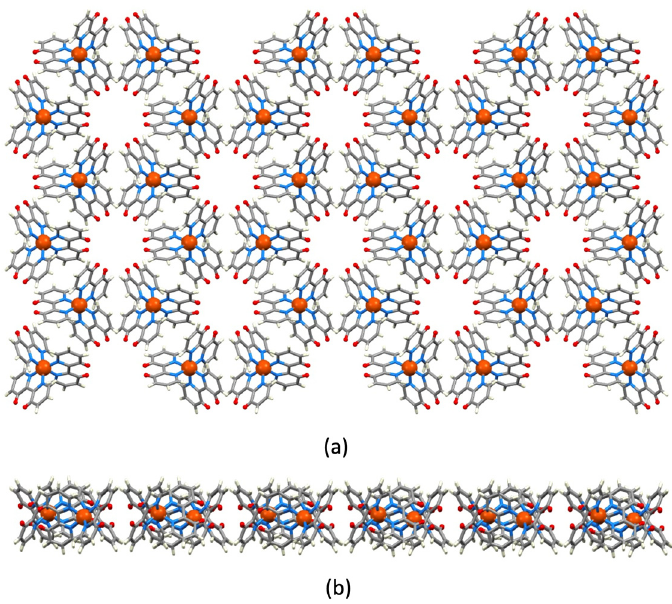
Figure 4. ( a ) Part of one sheet comprising ( ∆ )-[Fe(bpy) 3 ] 2+ cations in [Fe(bpy) 3 ] 2 [SO 3 ][OH] 4 . 14H 2 O (refcode YAWWAY [46]) with [SO 3 ] 2– , [OH] – and H 2 O omitted. ( b ) The same sheet section viewed from the side. The H3 and H3 ′ atoms are shown in red. Table 1. Structure Type I and II complexes with [XY 3 ] m – anions.